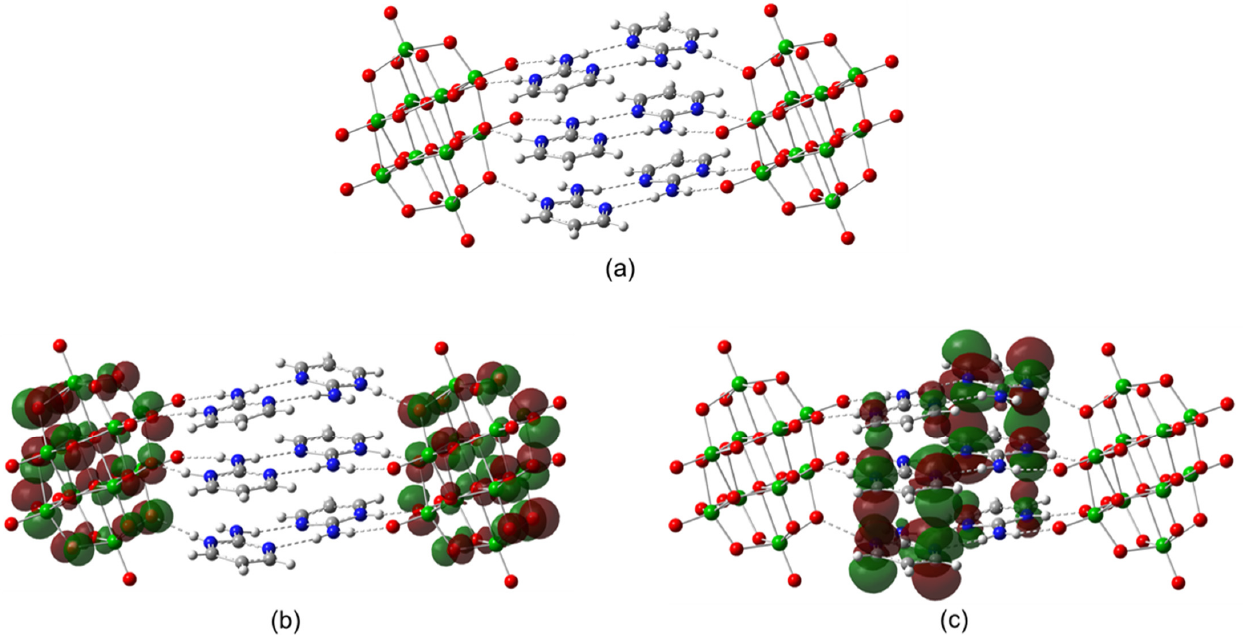
Figure 7. ( a ) Molecular structure, ( b ) HOMO isosurface, and ( c ) LUMO isosurface of Compound 1 calculated at the B3LYP/Def2SVP-LANL2DZ theory level using ECP = LANL2DZ for the V atom.